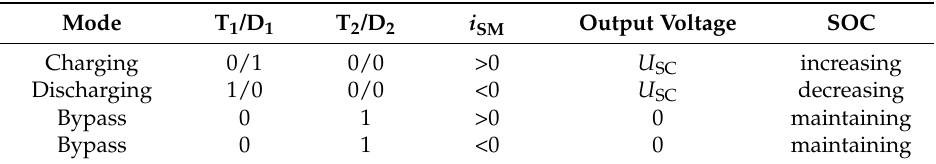
Table 1. Switching states of SCES-SM.